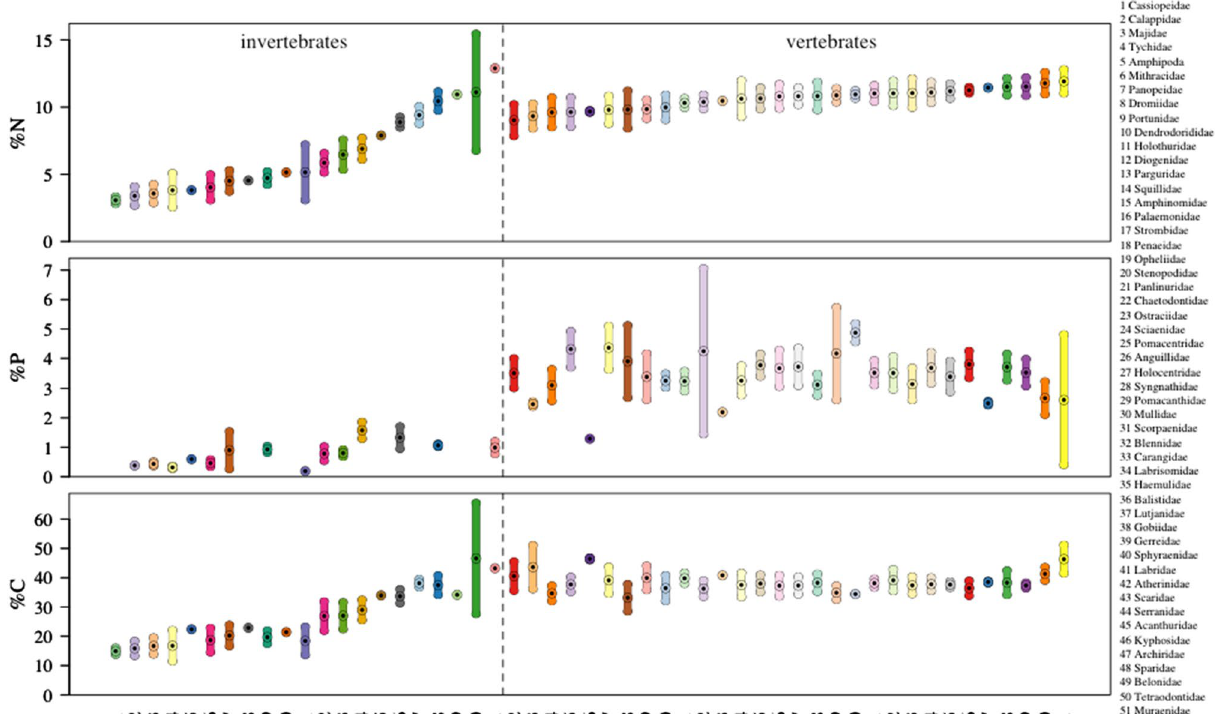
Figure 2. Raw values for C, N, and P across families delineated by invertebrates and vertebrates. Bars indicate standard deviation around the mean (center point with black dot). Family names are associated with numbers on the x-axis and the list on the right side of the figure (having a consistent color in all three plots). Families are ordered from smallest to largest %N body content for all three plots for ease of comparison across